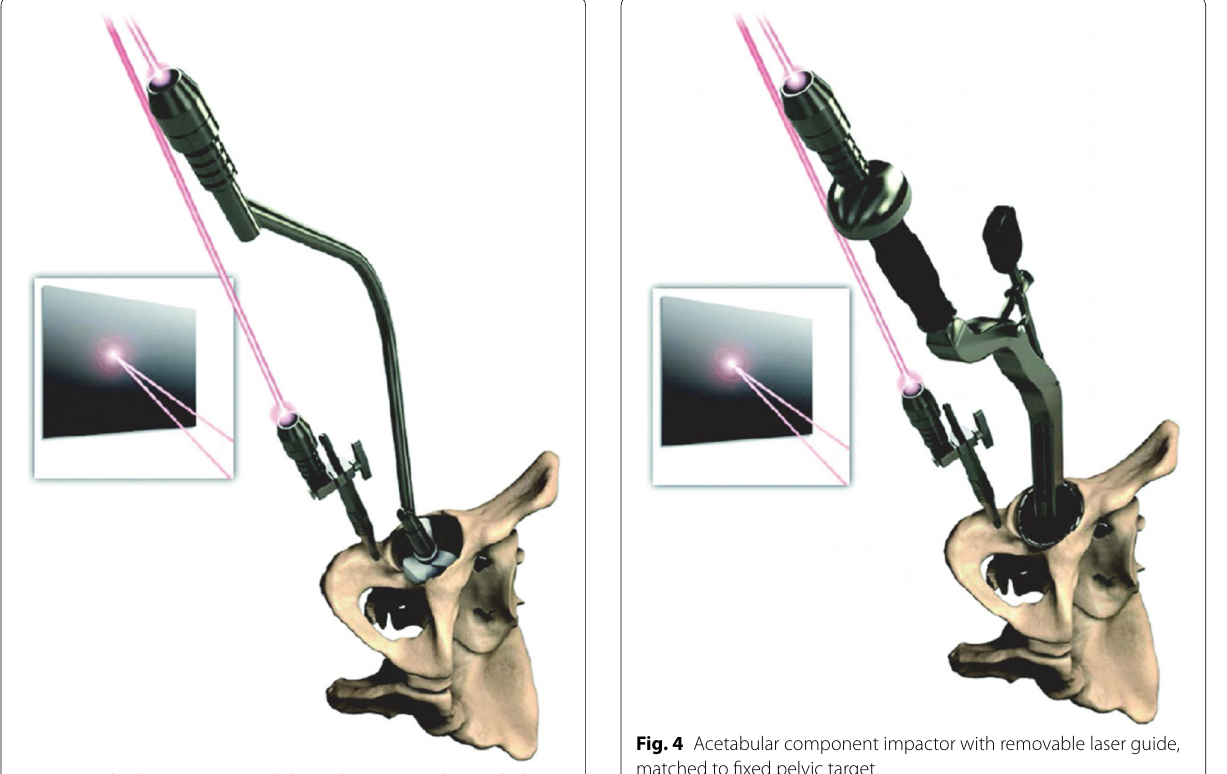
Fig. 3 Fixed pelvic pin in situ with laser alignment with acetabular